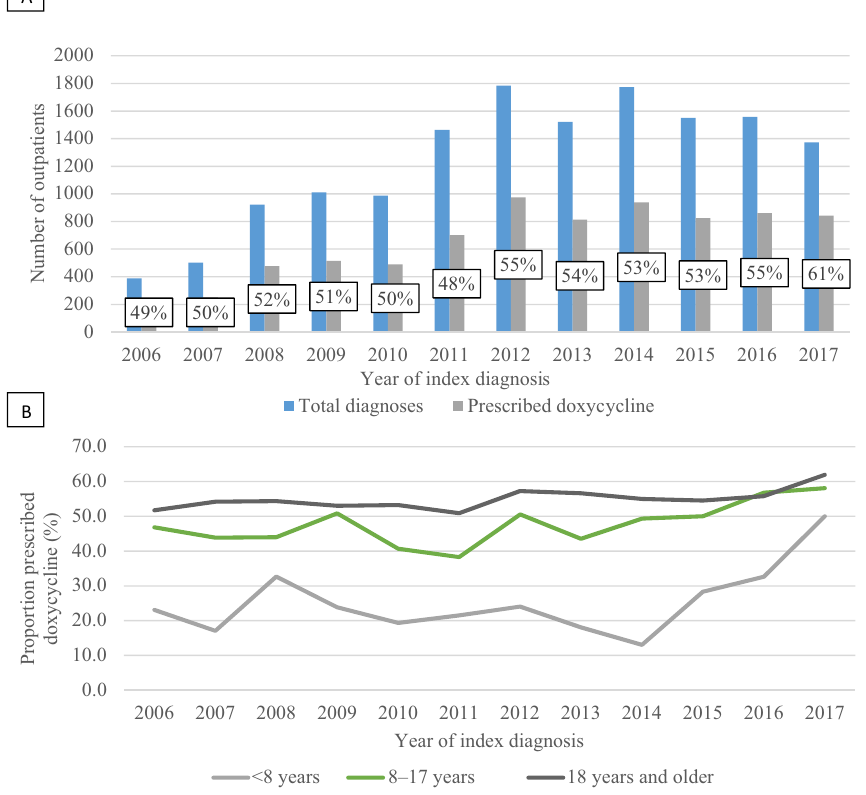
Figure 3. Number of outpatients with rickettsial diagnosis and percentage receiving doxycycline in a in a large, commercially insured population—United States, 2005–2017; by year ( A ) and by age group ( B ). Data